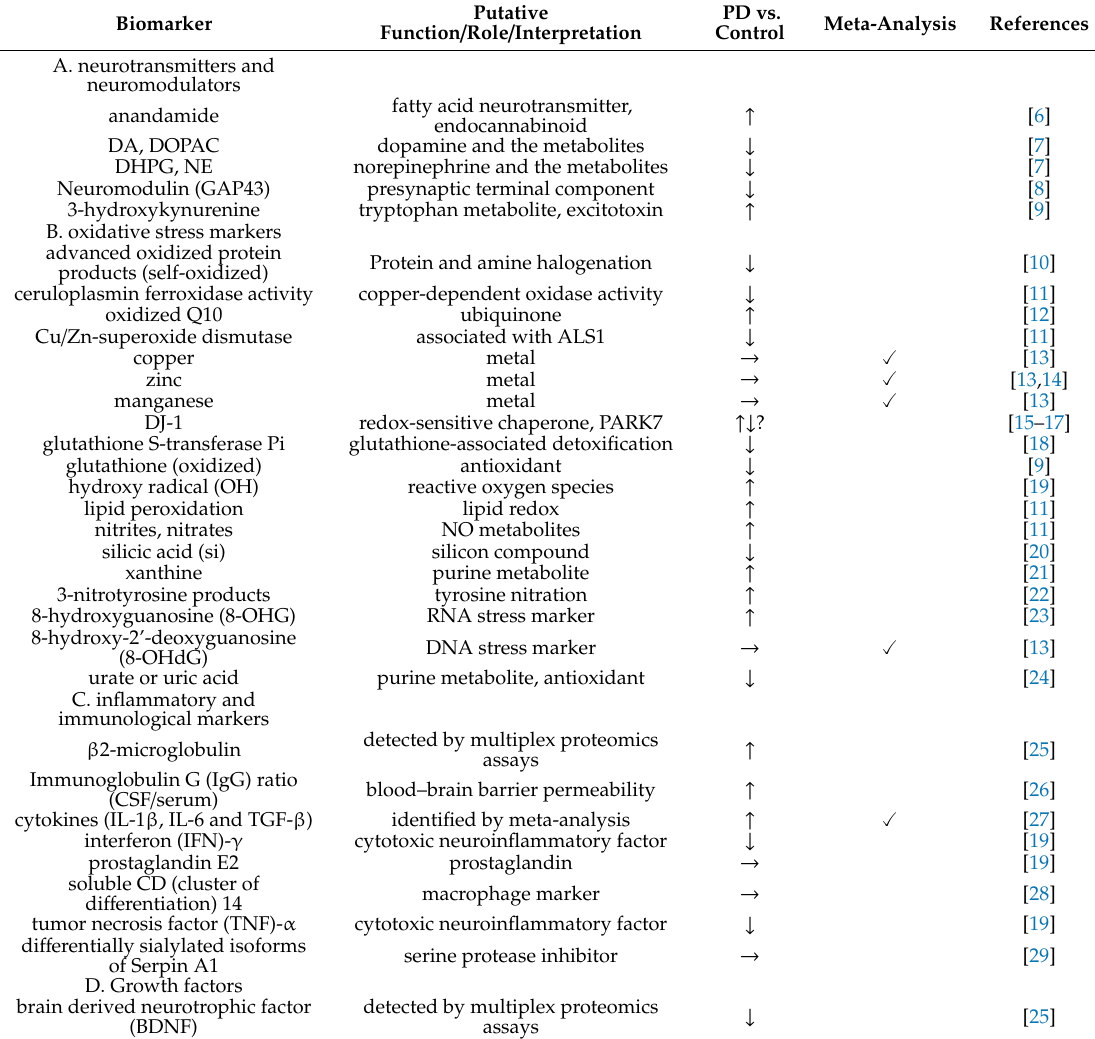
Table 1. Candidate cerebrospinal fluid biomarkers for distinguishing Parkinson’s disease from controls.